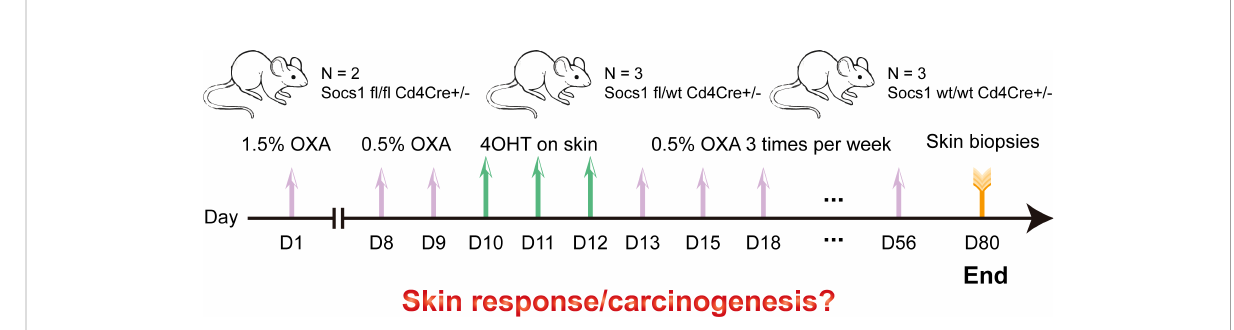
FIGURE 3 Scheme of the experiment performed using the conditional Socs1 knockout mouse model. OXA also on the